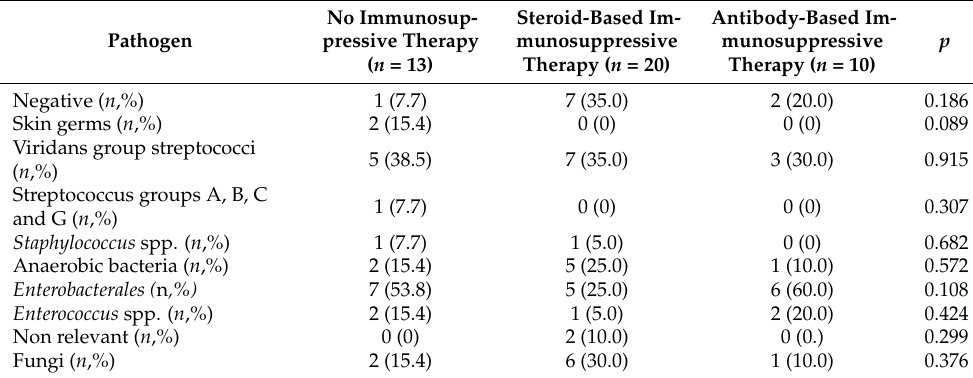
Table 3. Microbial spectrum and influence of immunosuppressive